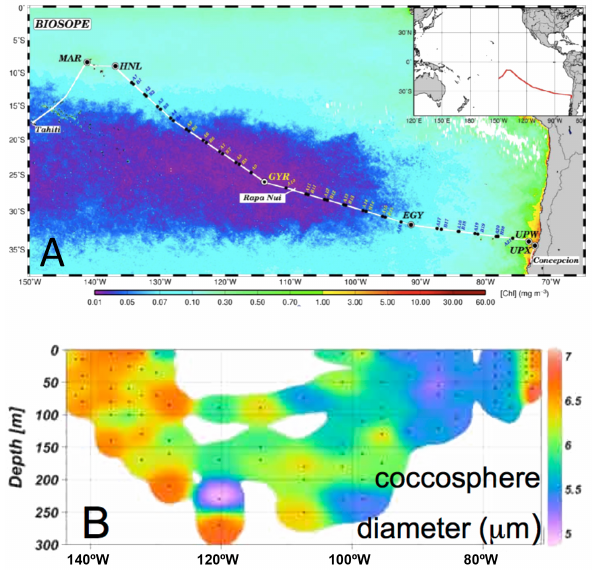
Figure 7. Geometry of Isochrysidales coccospheres along the BIOSOPE transect in the south-east Pacific ocean (Beaufort et al., 2008). (a) Geographical location of the BIOSOPE transect superim- posed on the surface ocean chlorophyll concentration map obtained by satellite observations, and (b) distribution of Isochrysidales coc- cosphere diameter in depth along the BIOSOPE transect determined by the SYRACO automated coccolith analyser system (Beaufort et al.,